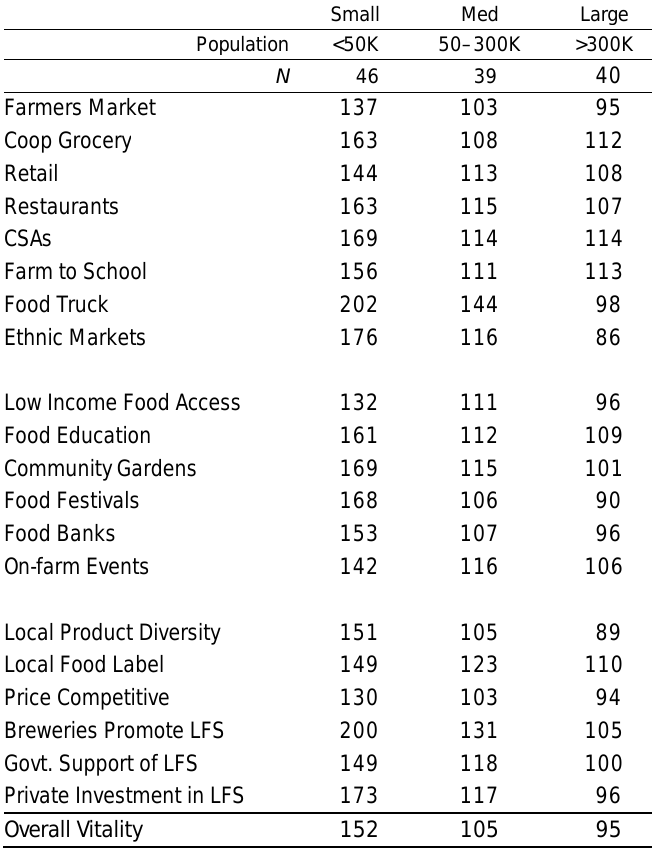
Table 4. Index Scores based on Previous Community